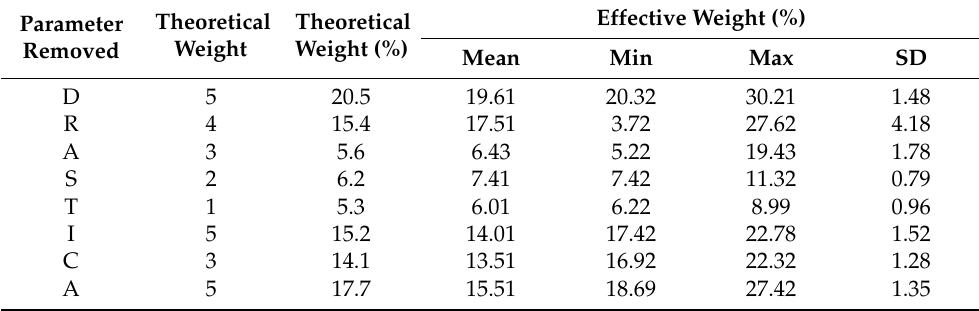
Table 8. Statistics of single-parameter-based